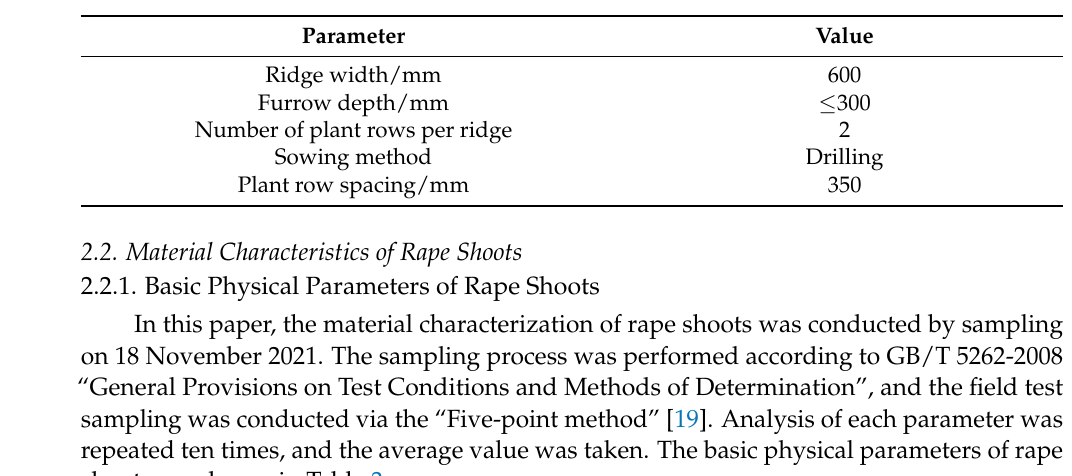
Table 2. Planting parameters of rape shoots.